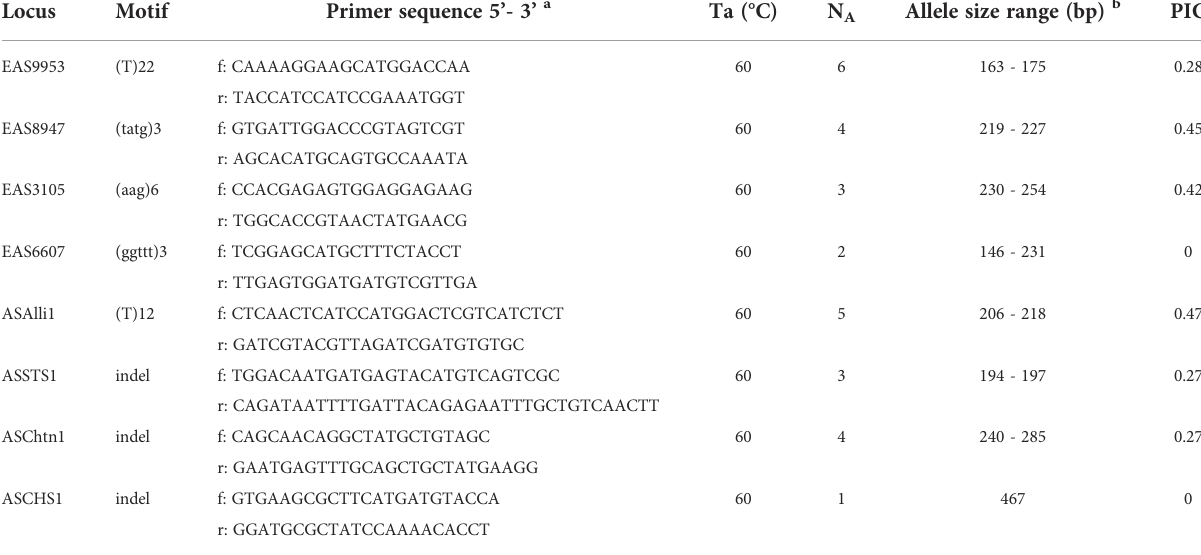
TABLE 1 Molecular markers used in this